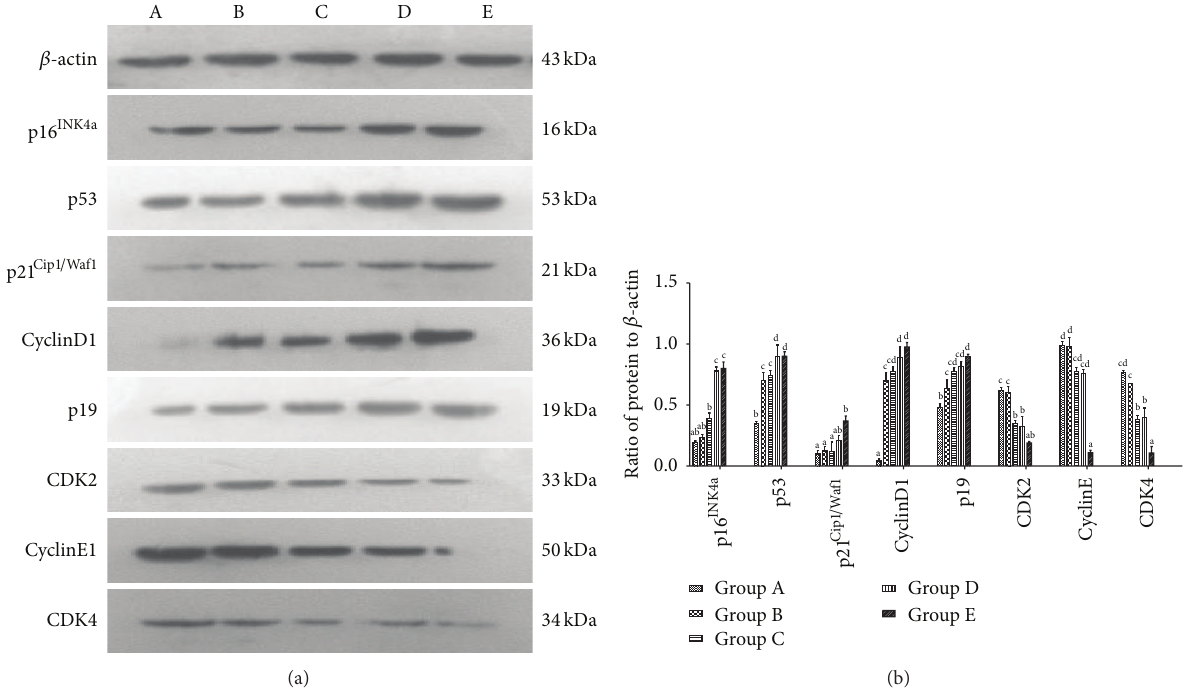
Figure 7: Protein expression of P16 INK4a , P53, P21 Cip1 / Waf1 , CyclinD1, P19, CDK2, CyclinE, and CDK4 in Sca-1 + HSPCs. (a) Result of western blot. A: Group A (3-4-week-old mice, 13–16 g in body weight), B: Group B (8-9-week-old mice, 20–25 g in body weight), C: Group C (6- month-old mice, 35–40 g in body weight), D: Group D (12-month-old mice, 39–43 g in body weight), and E: Group E (18-month-old